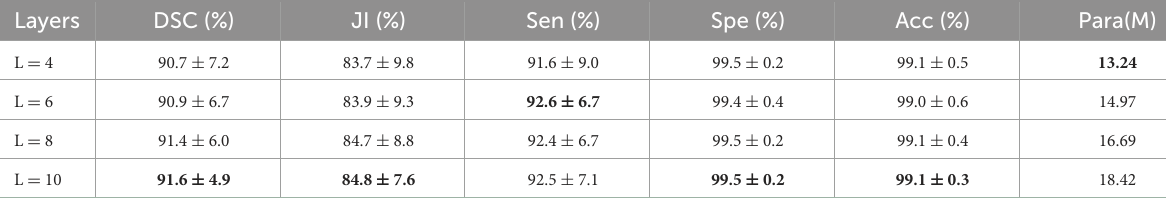
TABLE 3 Effect of setting different convolution layers in single dense aggregation block on network performance.